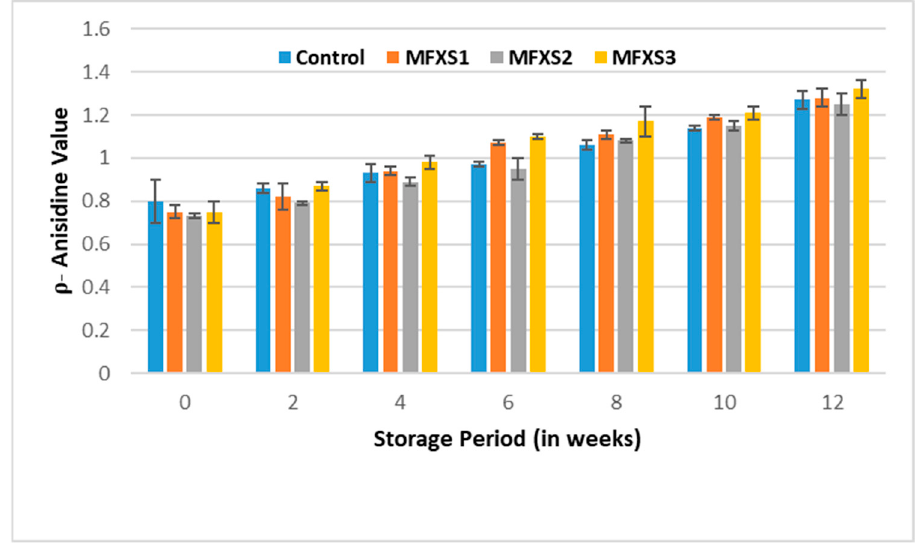
Figure 8. Anisidine value of mayonnaise samples during cold storage (7 ± 2 °C). Control sample: 70% soy bean oil, MFXS1: 20% flaxseed oil and 50% soy bean oil, MFXS2: 30% flaxseed oil and 40% soy bean oil, and MFXS3: 40% flaxseed oil and 30% soy bean oil.